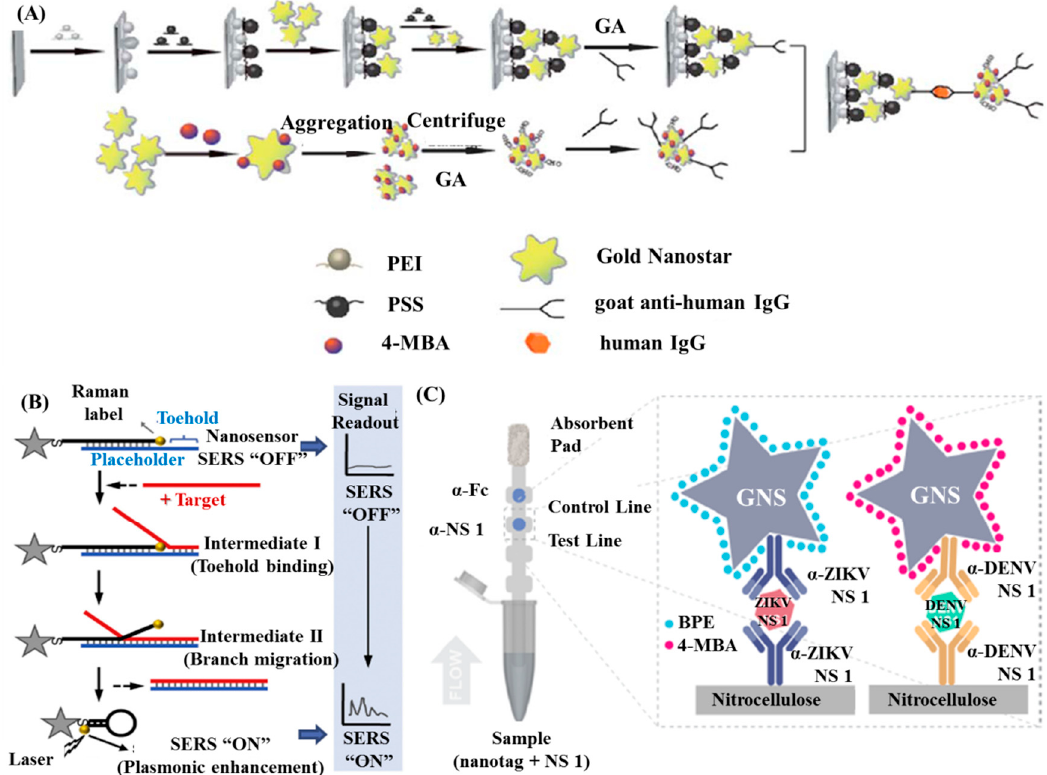
Figure 5. SERS-based immunoassay using Au NSs: ( A ) Schematic diagram of the synthesis route of immune nanostar aggregates and SERS-active substrates. Reproduced with permission from reference [97]. ( B ) Detection scheme of the ‘turn on’ SERS nanobiosensor. Reproduced with permission from reference [98]. ( C ) Sandwich immunoassay for ZIKV and DENV NS 1. Reproduced with permission from reference [99]. Copyright Royal Society Chemistry, 2013; Copyright Elsevier, 2015; Copyright American Chemical Society, 2015; Copyright American Chemical Society, 2017.